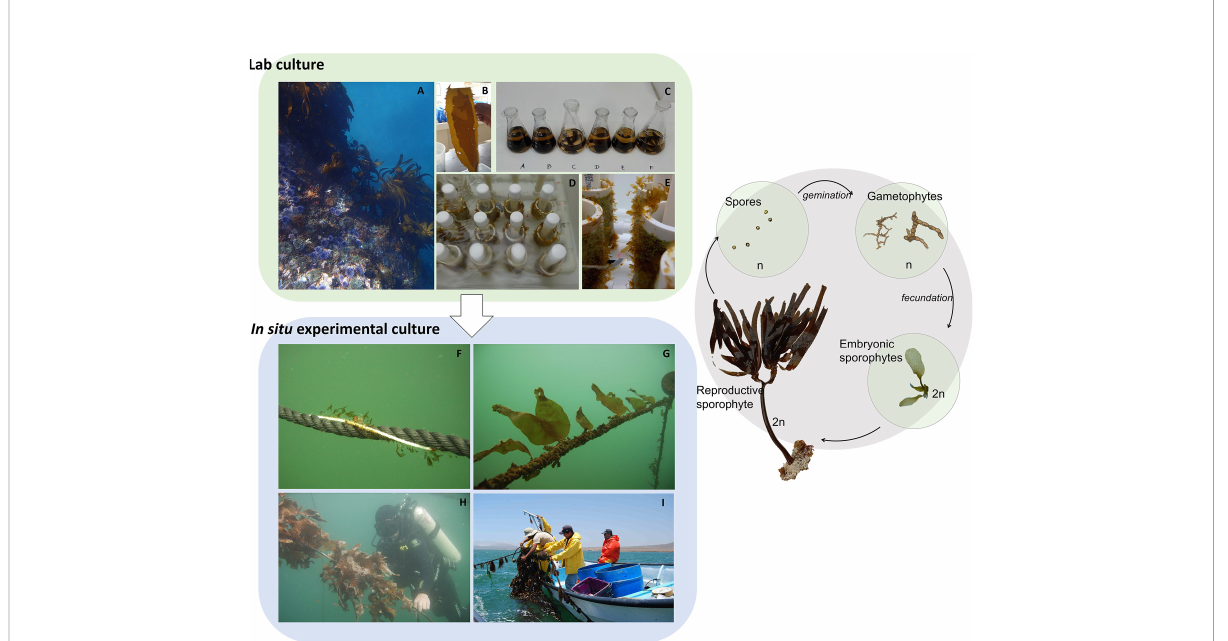
FIGURE 1 On the left: Pictures showing the different stages of Eisenia arborea culture. In natural populations of E. arborea (A) , reproductive blades with sori (B) , were collected from mature sporophytes. In the laboratory, sori were induced for spore release (C) . Spores were germinated on nylon strings wrapped around PVC tubes placed in tanks fi lled with seawater. Embryonic sporophytes growing on nylon strings (D, E) were transferred to in situ cultures, wrapping them around polypropylene ropes. Juvenile sporophytes (G) grew over these polypropylene ropes until maturity (H) . Harvesting and sampling of plants performed by scuba diving (I) . On the right: Schematic representation of the life history of Eisenia arborea